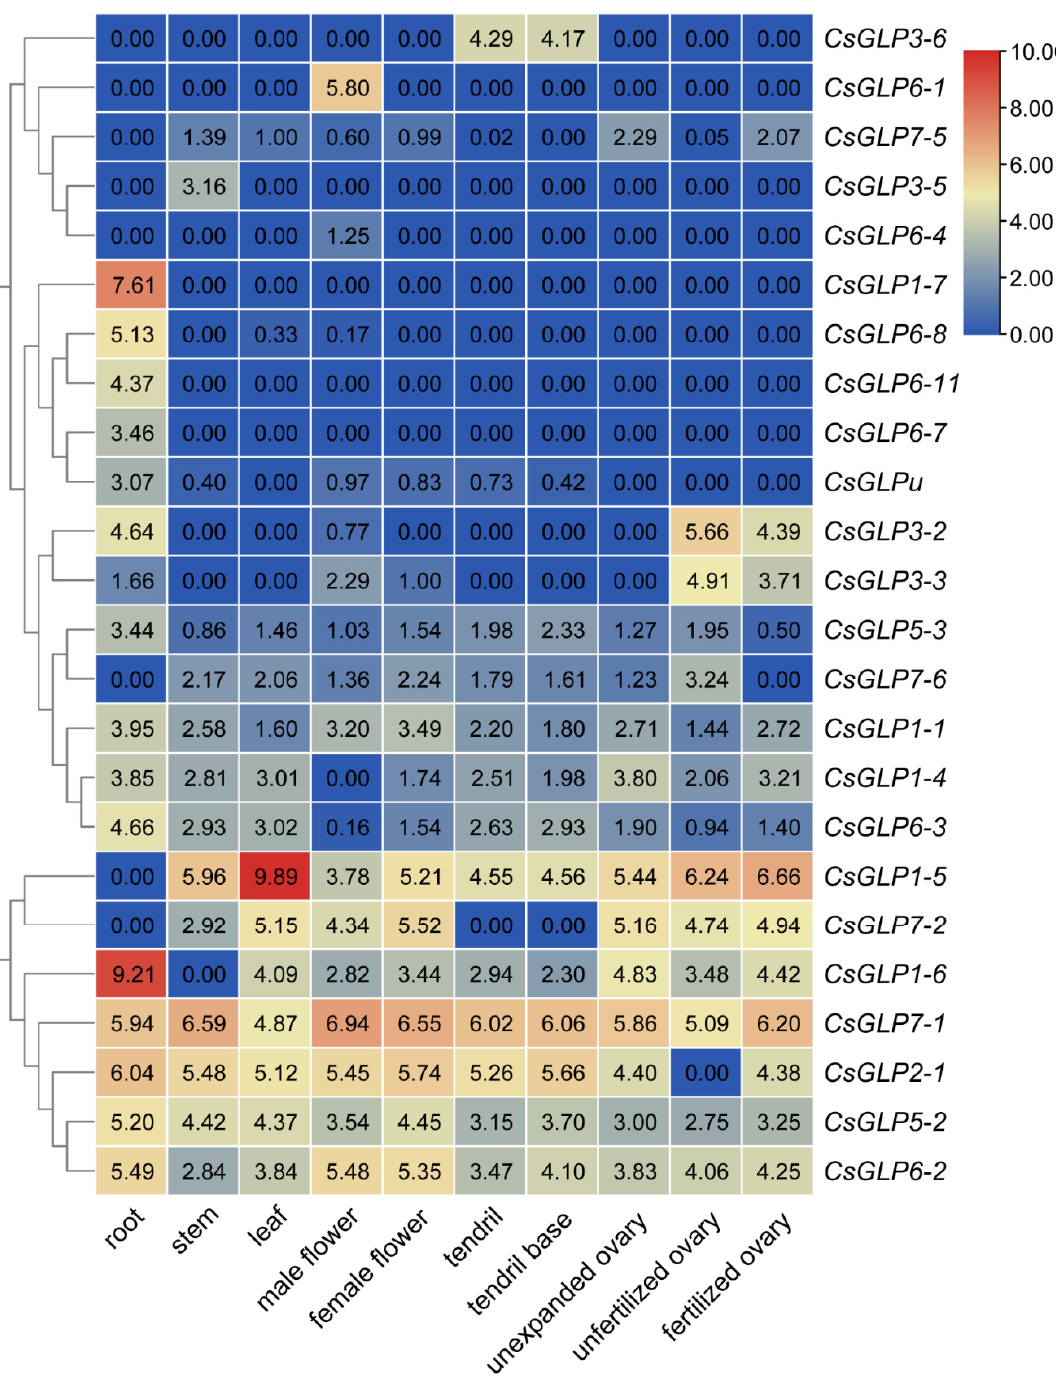
Figure 5. Expression levels of CsGLP genes in different cucumber tissues.